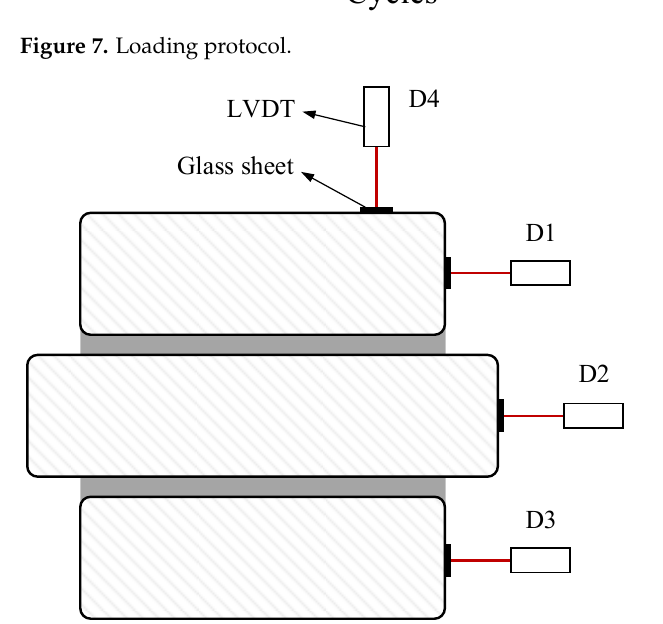
Figure 7. Loading protocol.